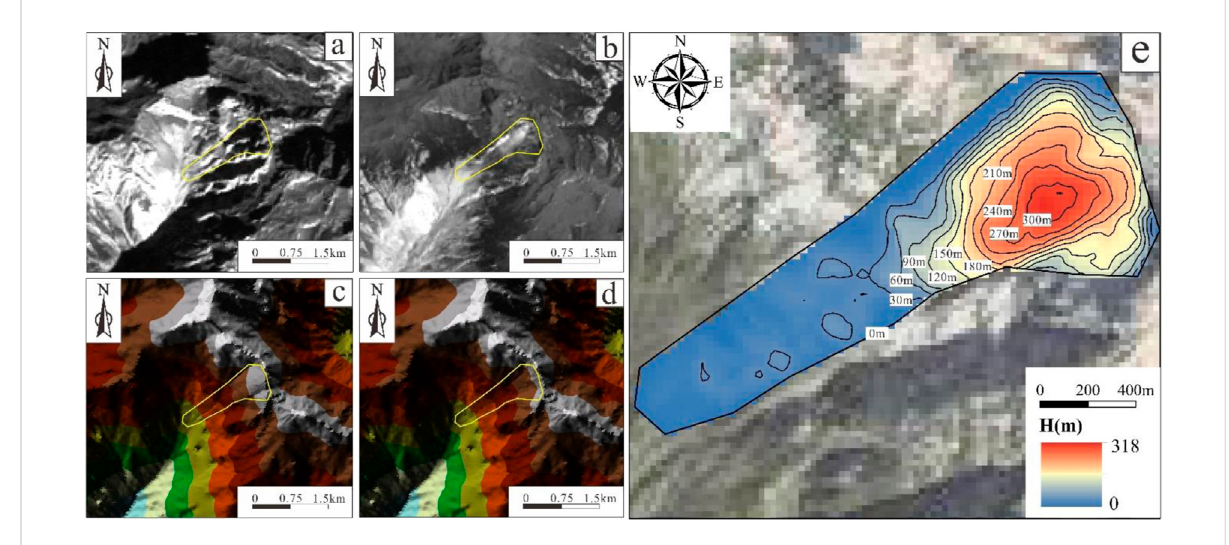
FIGURE 3 Comparison of Yigong Landslide ’ s slide source zone before and after sliding in 2000 (A,B) -the images are Landsat5 and 7 images, according to USGS: http://glovis.usgs.gov/; (C,D) -the tin fi les generated after terrain restoration based on AW3D30 DEM, according to JAXA (Japan Aerospace Exploration Agency), https://www.eorc.jaxa.jp/ALOS/en/aw3d30; (E) -restored sliding body of 2000 Yigong